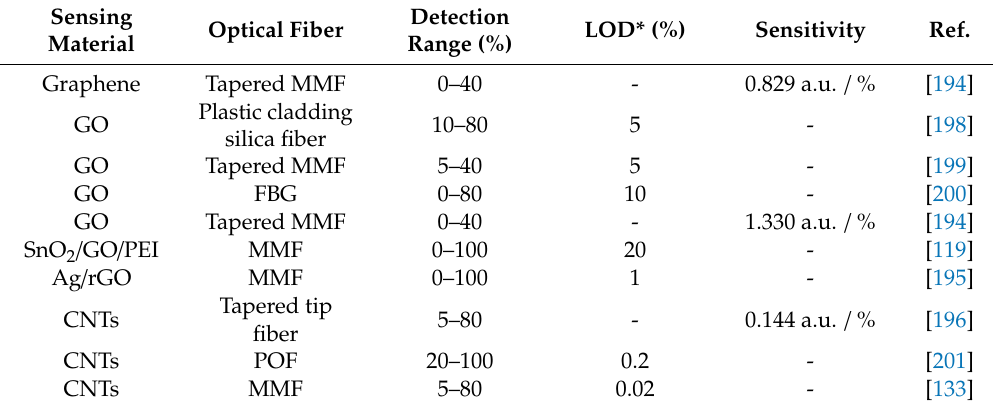
Table 6. Summary of carbon allotrope-based OFS for ethanol